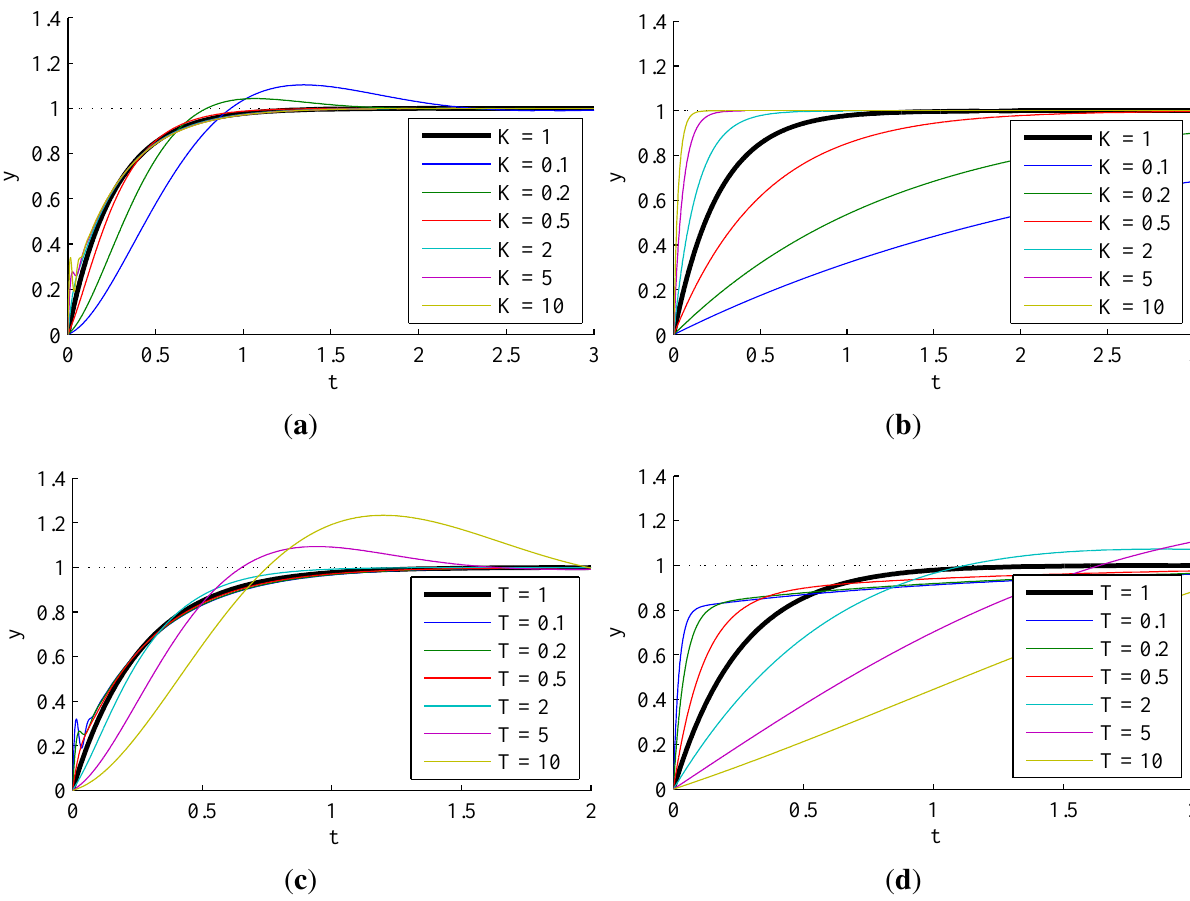
Figure 9. Experiment 3.1.6: comparison of first-order ADRC and PI controller faced with varying process parameters, K and T . Nominal process and ADRC parameters are as throughout Section 3.1. For each combination, the closed loop step response is